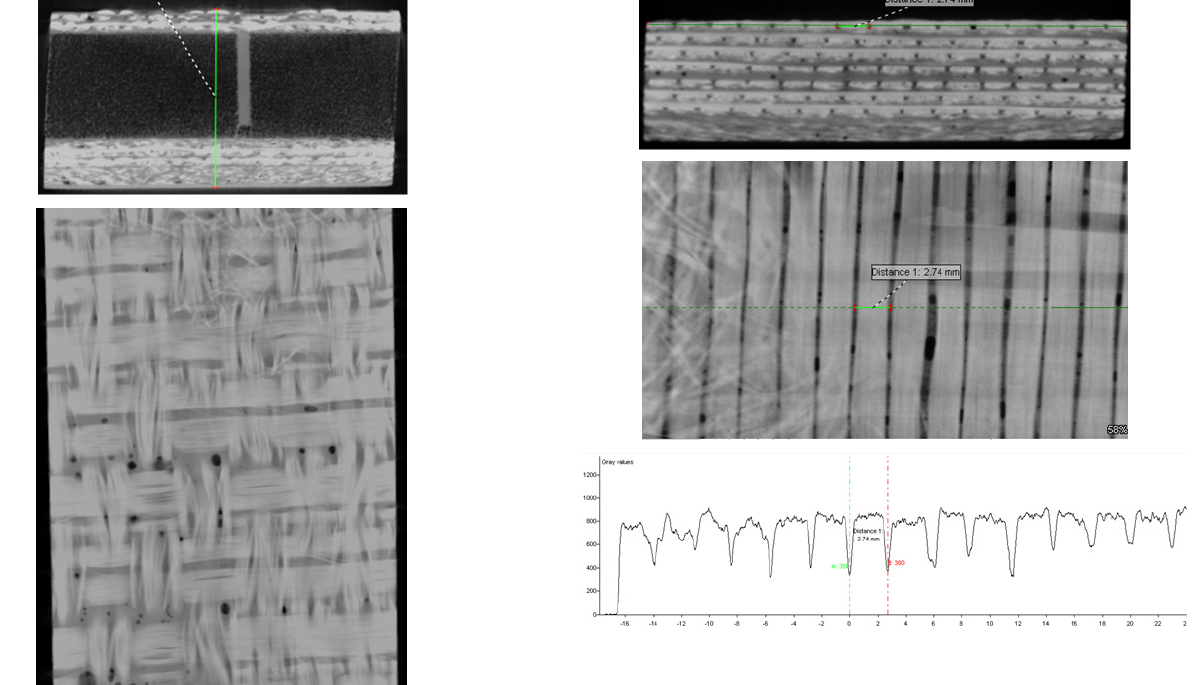
Figure 6: CT analysis of a polymeric sandwich composite. Figure 7: CT analysis of a laminated